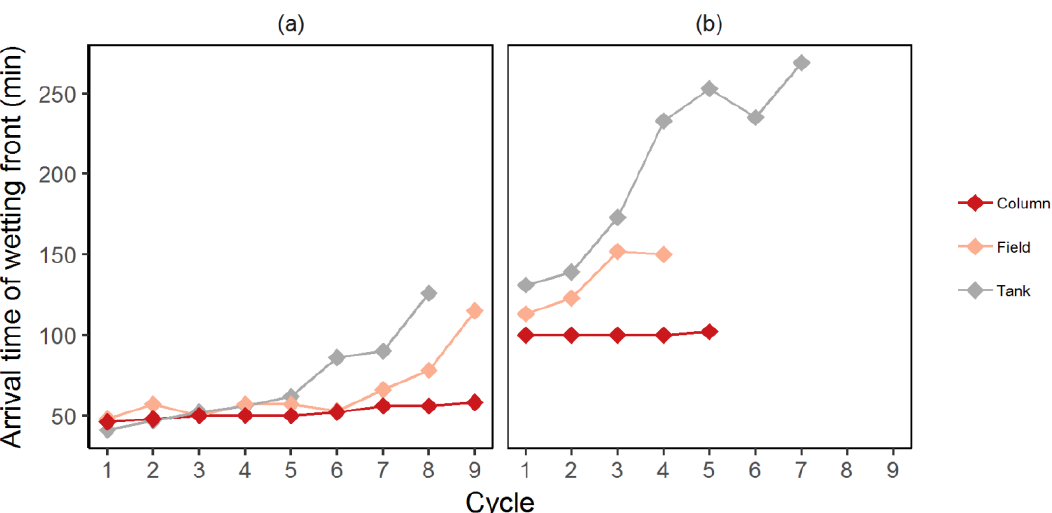
Figure 6. Flow time between soil surface and 0.7 m depth for ( a ) scenario 3 and ( b ) scenario 4. Scenarios were aborted when overflow was detected, leading to different numbers of cycles for the setups (adapted from Fichtner et al. [27]).